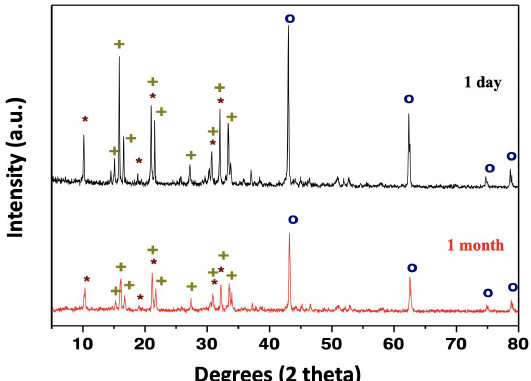
Figure 9. FTIR spectra of the surface region of the magnesium phosphate cements prepared from MgO powders calcined